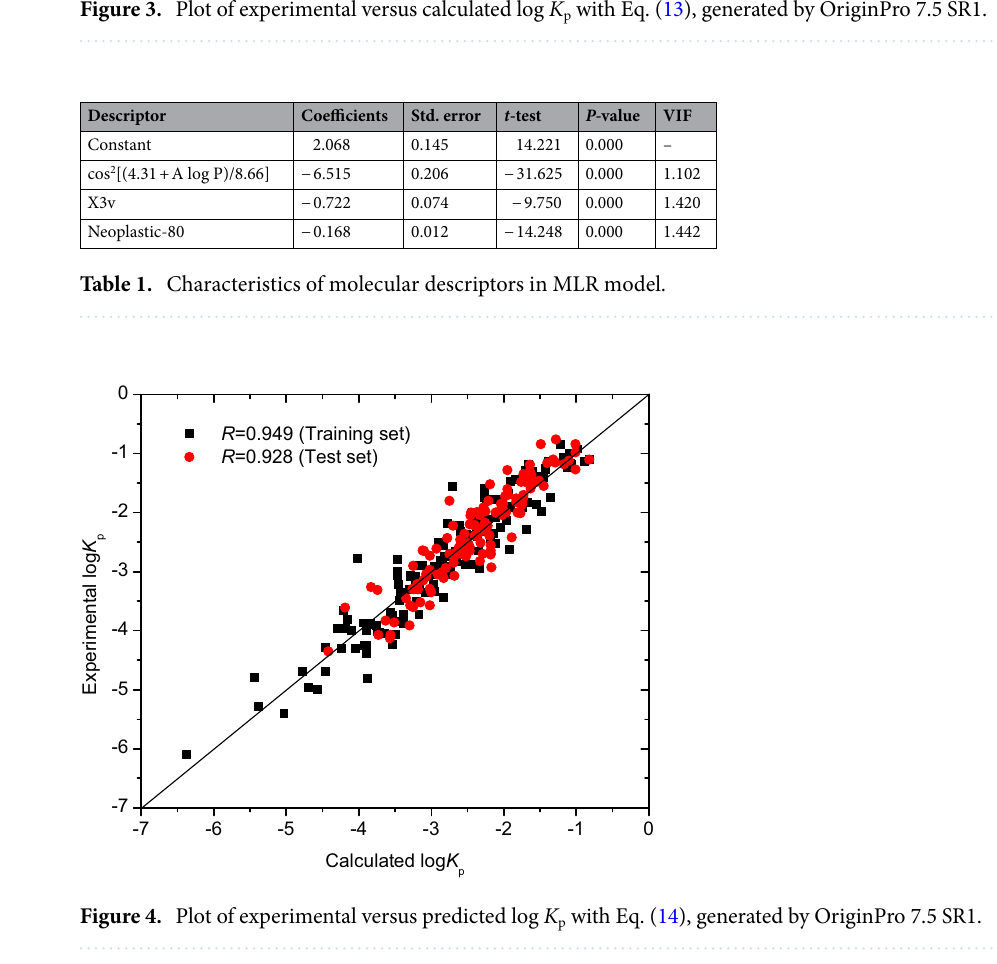
Figure 3. Plot of experimental versus calculated log K p with Eq. (13), generated by OriginPro 7.5 SR1.